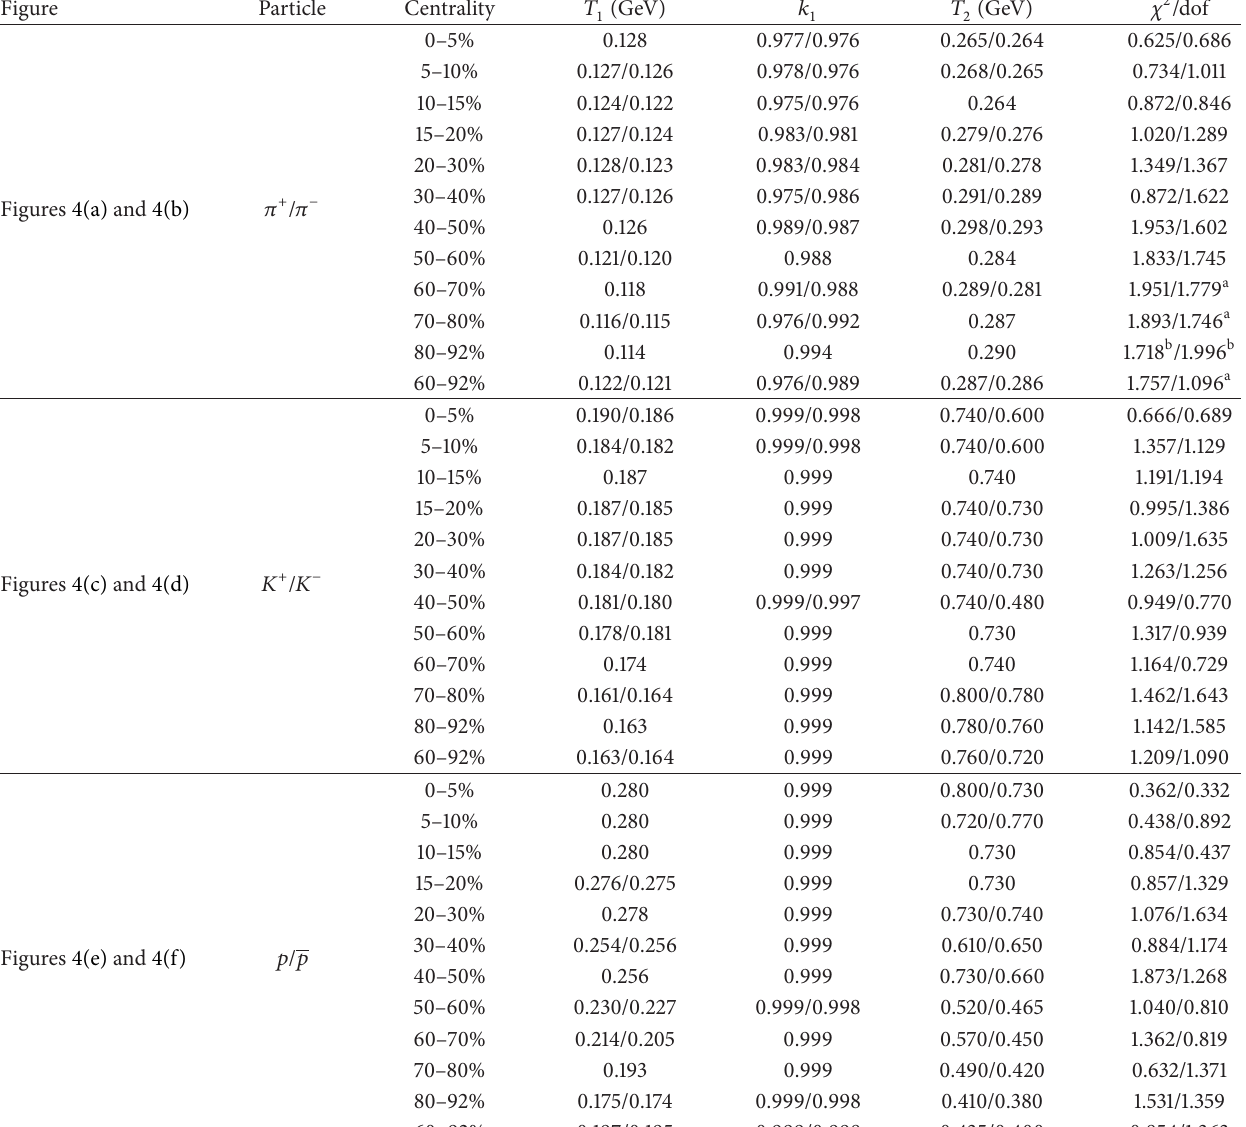
Table 3: The same as that for Table 2, but showing the results corresponding to the curves in Figure 4 for Au-Au collisions at √𝑠 𝑁𝑁 = 200 GeV. Figure Particle Centrality 𝑇 1 (GeV) 𝑘 1 𝑇 2 (GeV) 𝜒 2 /dof